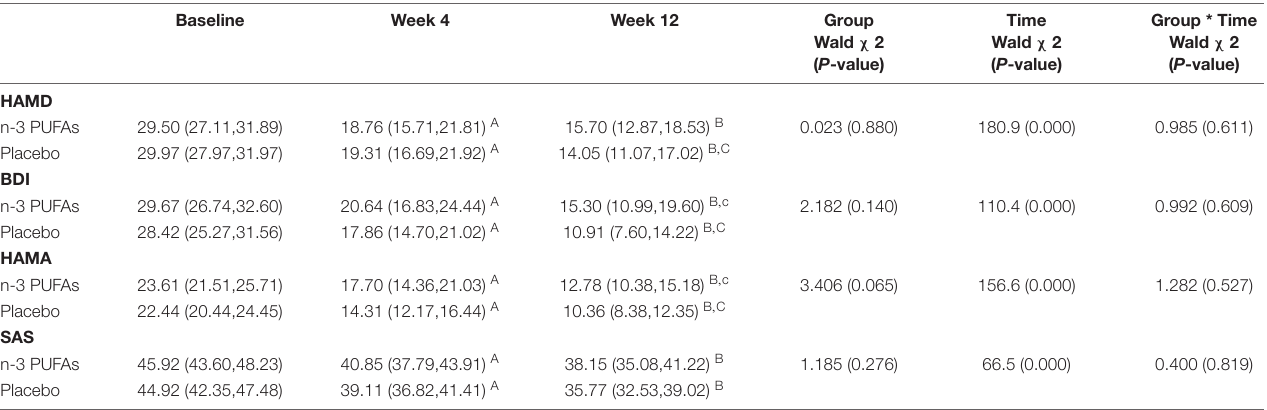
TABLE 2 | The scores on depression and anxiety questionnaires in n-3 PUFAs and placebo group.